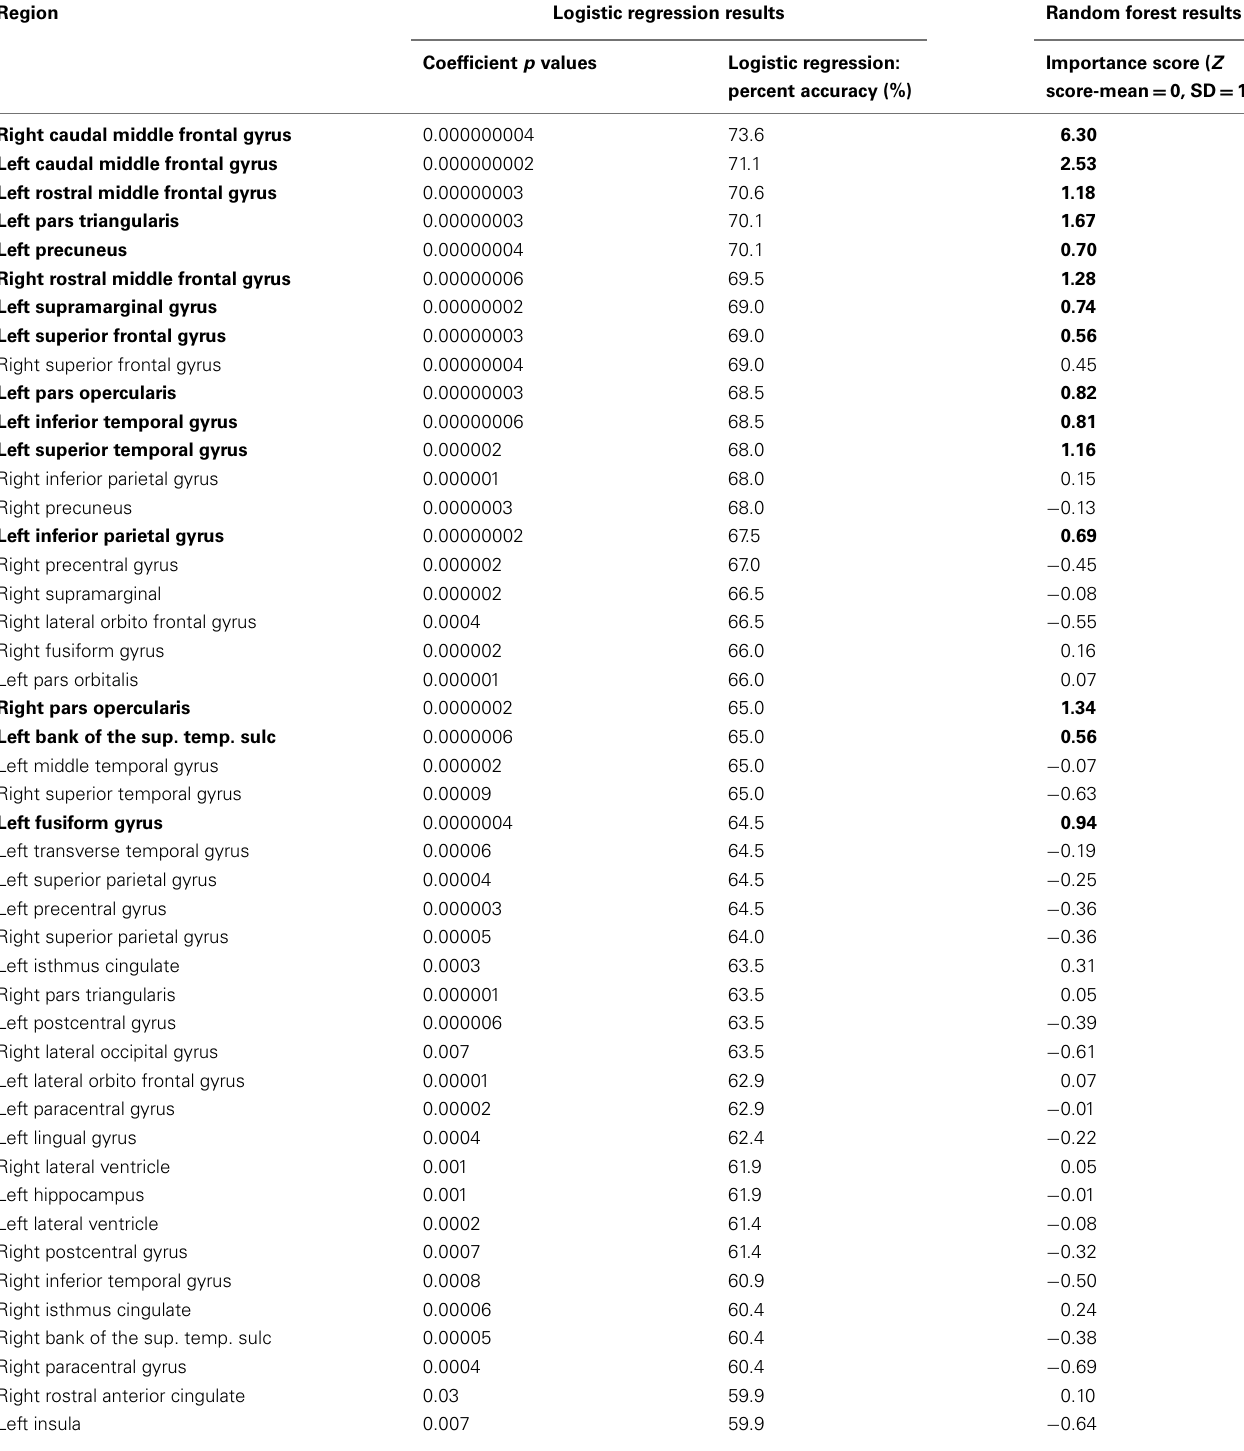
TableA1 |All 74 regions sorted by univariate logistic regression percent accuracy and Random Forest importance score (top 15 importance scores with greater than Z > 0.05 in